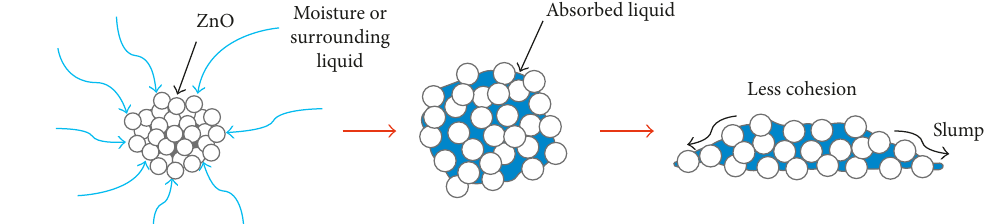
Figure 7: Slumping mechanism of the SAC0307-xZnO solders at room temperature.